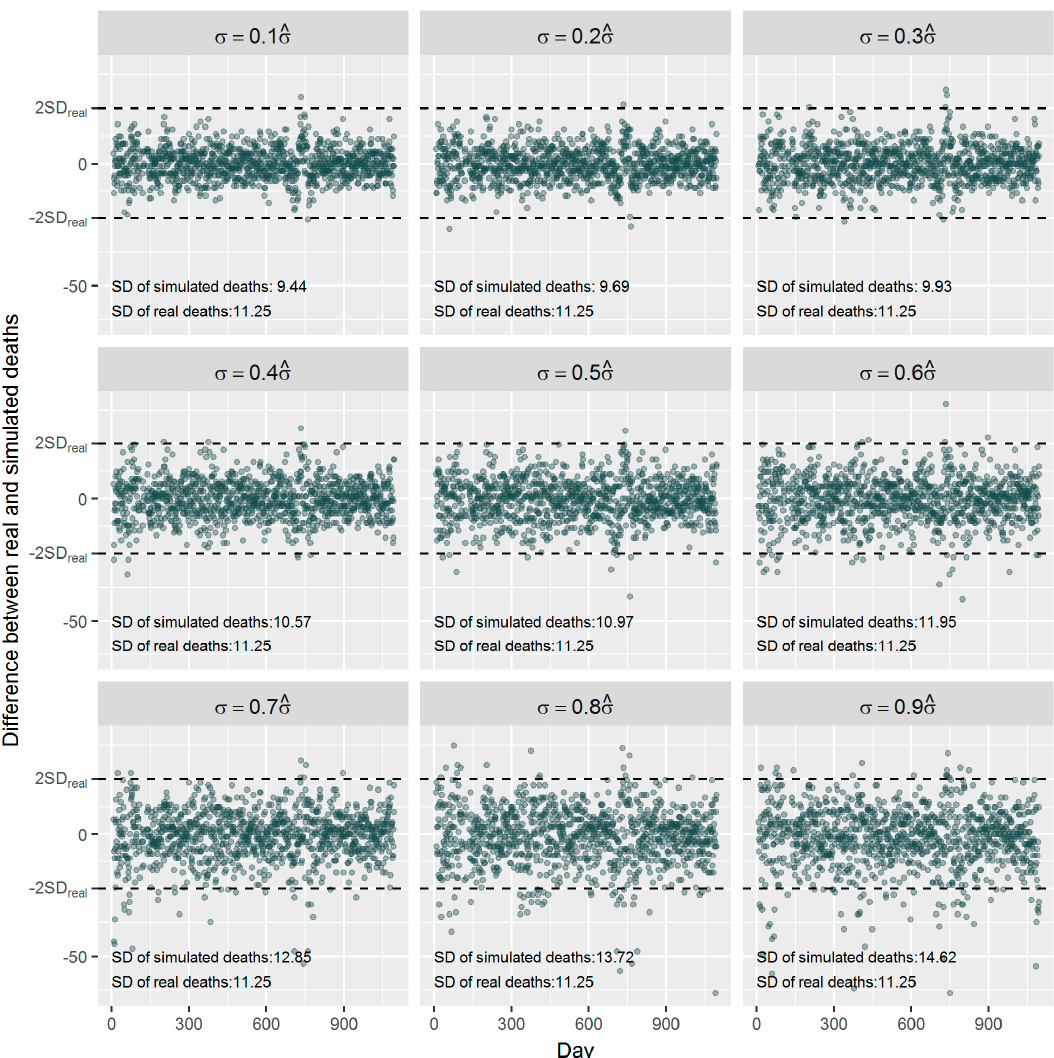
Figure 4. Examples of the difference between the real and the simulated daily respiratory deaths with different random noises.